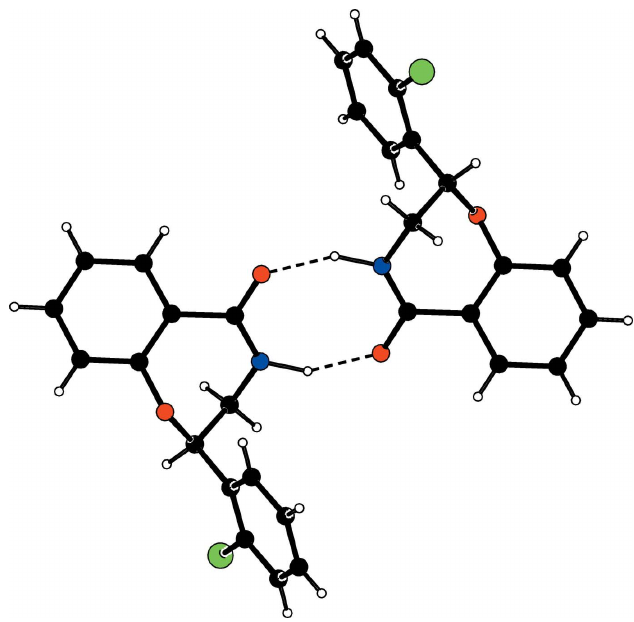
Figure 2 An inversion dimer of the title compound. Hydrogen bonds are shown as dashed